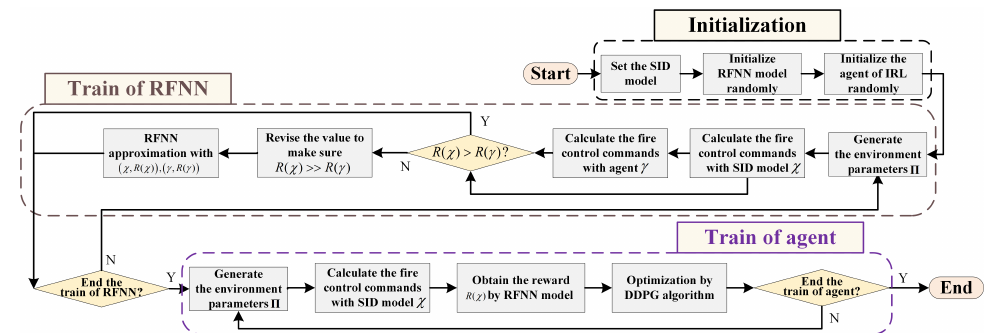
Figure 6. The flow diagram of the SID-IRL model.